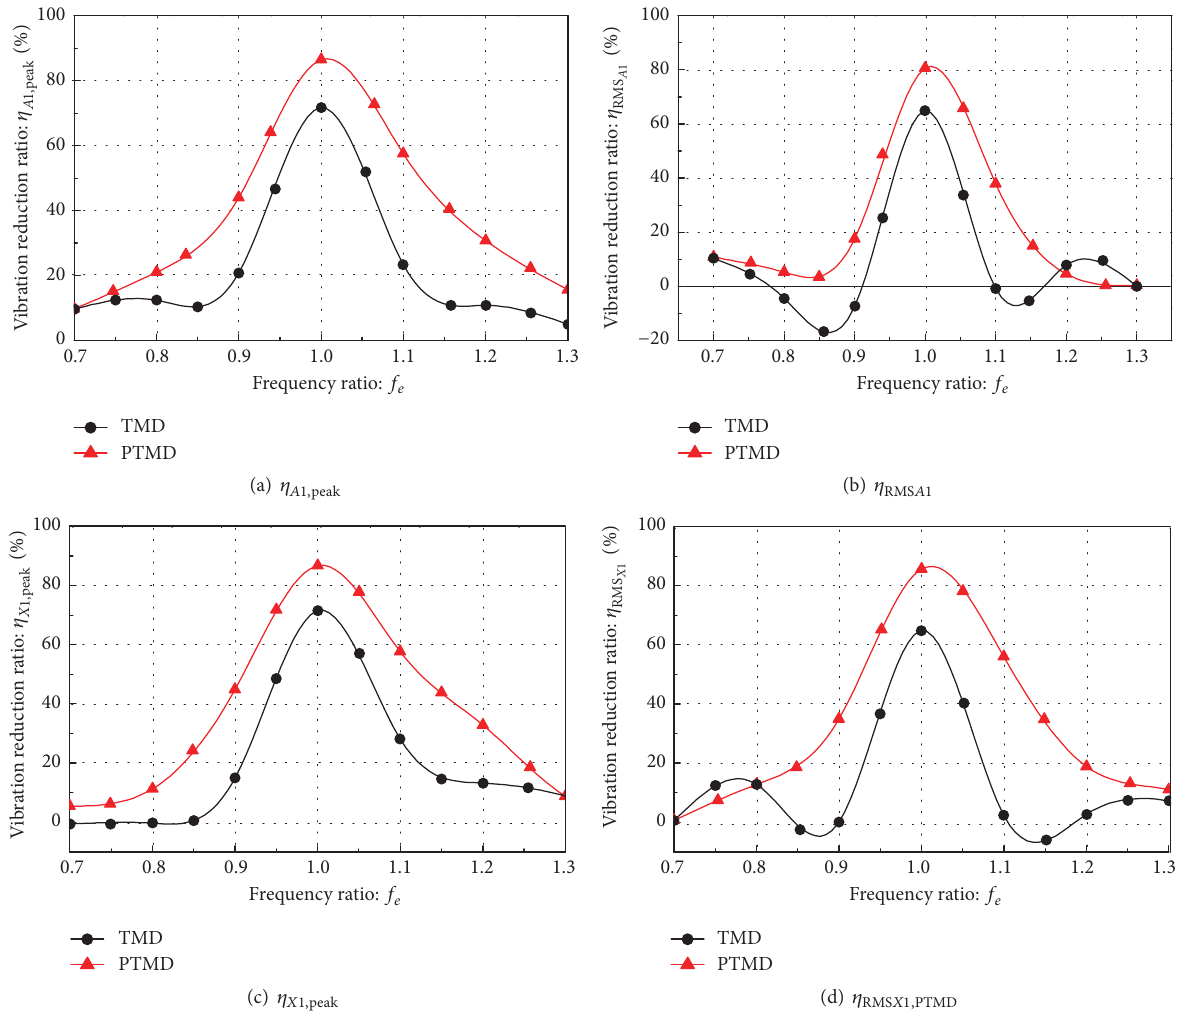
Figure 12: The comparison of 𝜂 between PTMD and TMD with optimal parameter (PTMD: 𝜉 2 = 3𝜉 𝜇 = 2 %).